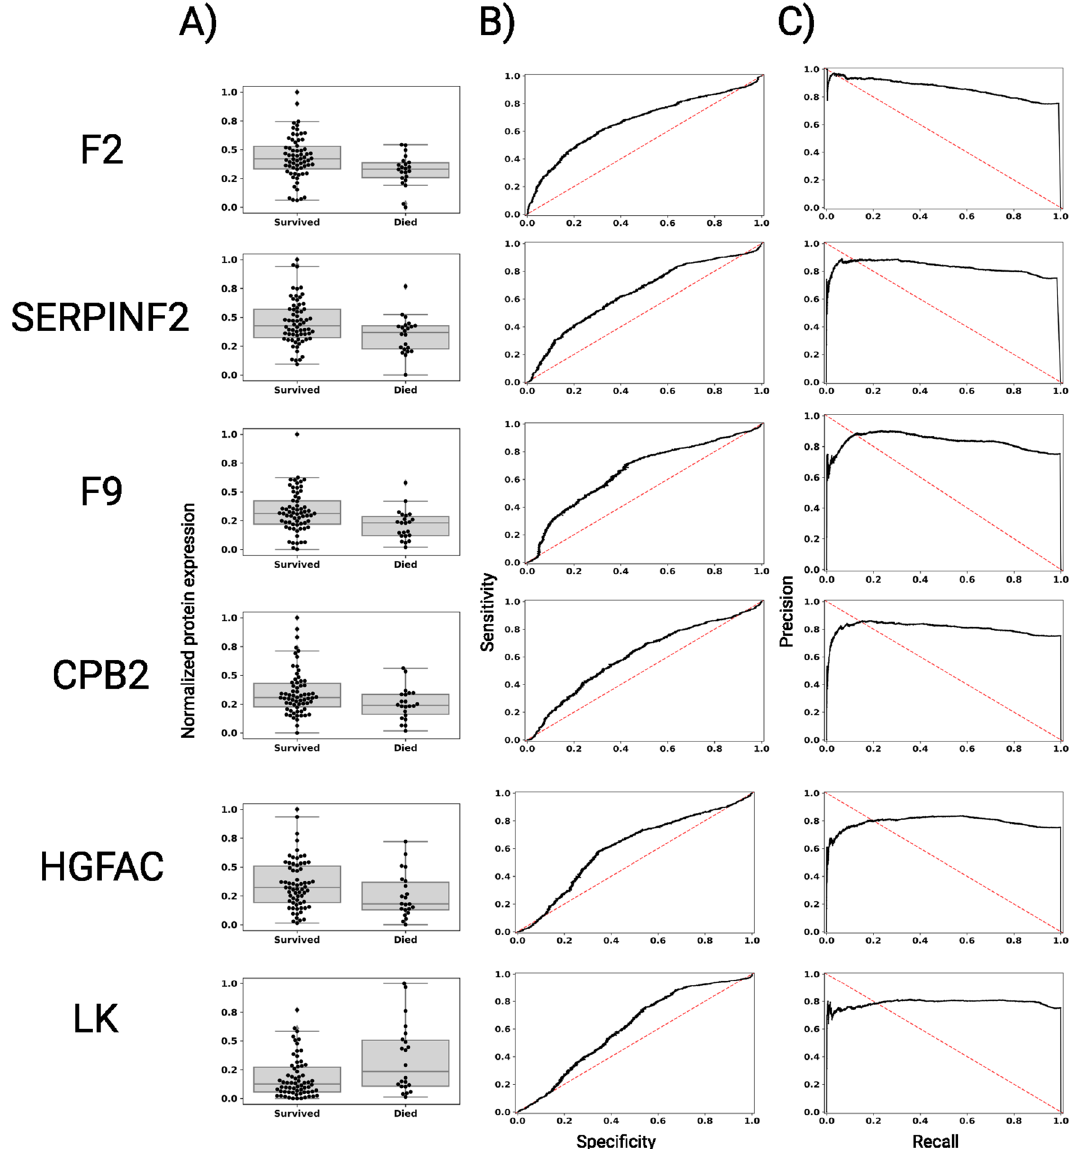
Figure 3. Predictive protein distributions and performance for post-transplant survival. For the highly predictive proteins (AUROC > 0.6), we show ( A ) the maximum-minimum normalized protein distributions for patients (and replicate samples) grouped by patients who survived or died after heart transplant, ( B ) the receiver operating characteristic (ROC) curve between sensitivity and 1-specificity, and ( C ) the precision-recall